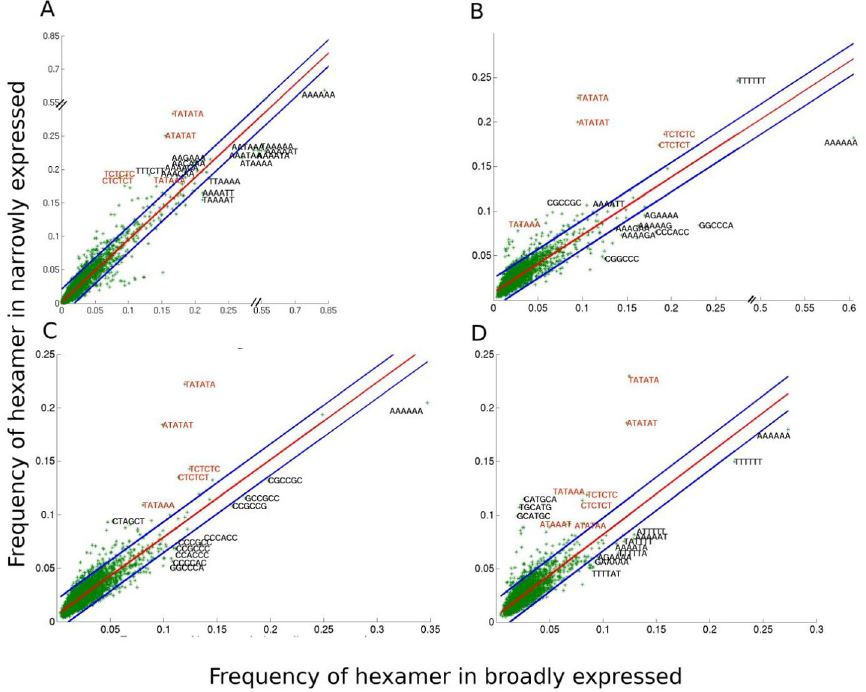
Fig 7. Hexamer distribution plot shows the preferred hexamers in the promoter regions (-200 to 0) of broadly and narrowly expressed genes of arabidopsis (A), rice (B), sorghum (C) and maize (D). All possible hexamers of 10% broadly and narrowly expressed genes are plotted with red line as best fit line and blue lines are the 2 σ deviated from best fit. Top ten enriched hexamers of broadly and narrowly expressed sets from 2 σ deviated dataset are labelled here. Hexamers that match with the consensus motif of TATA and Y-patch are shown in red